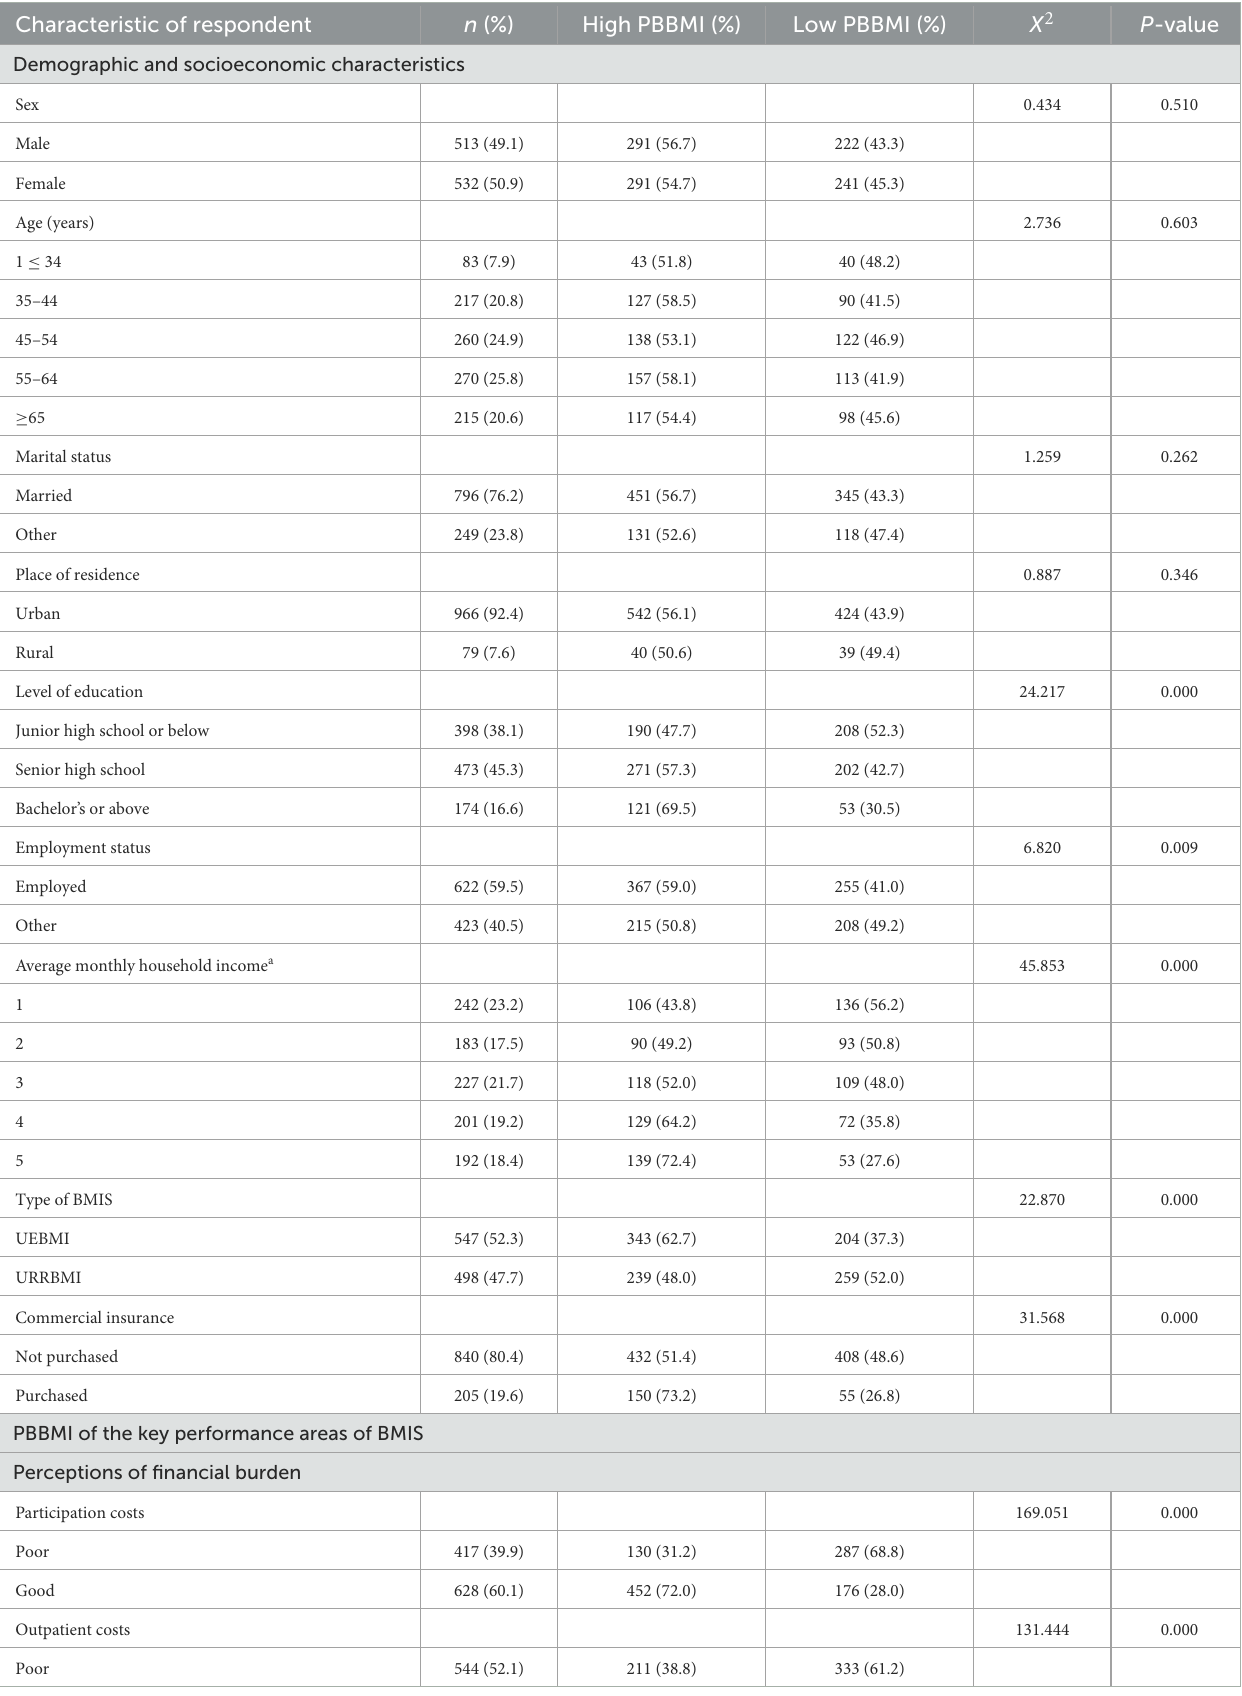
TABLE 1 Characteristics of respondents and overall PBBMI ( n =